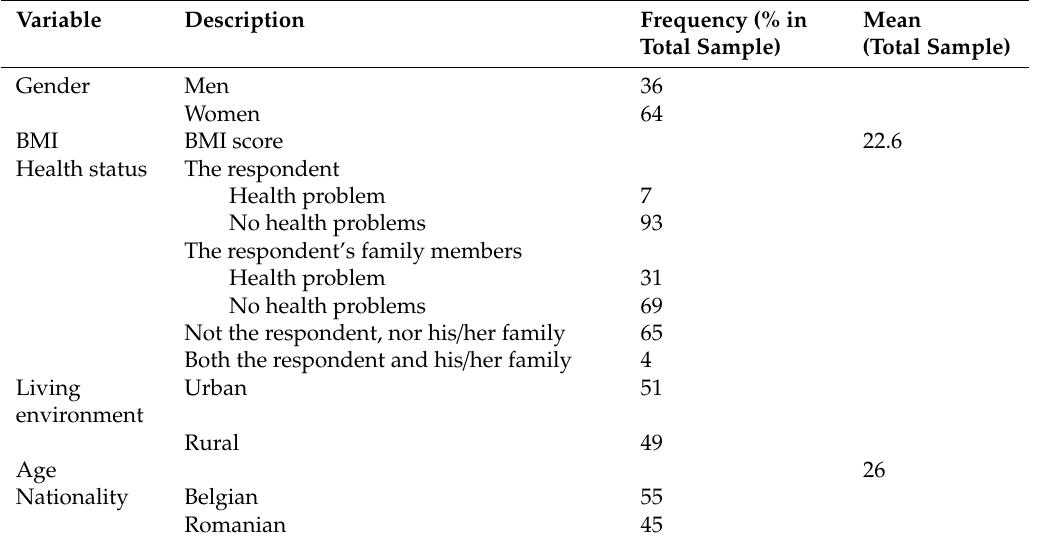
Table 2. Summary statistics (N =